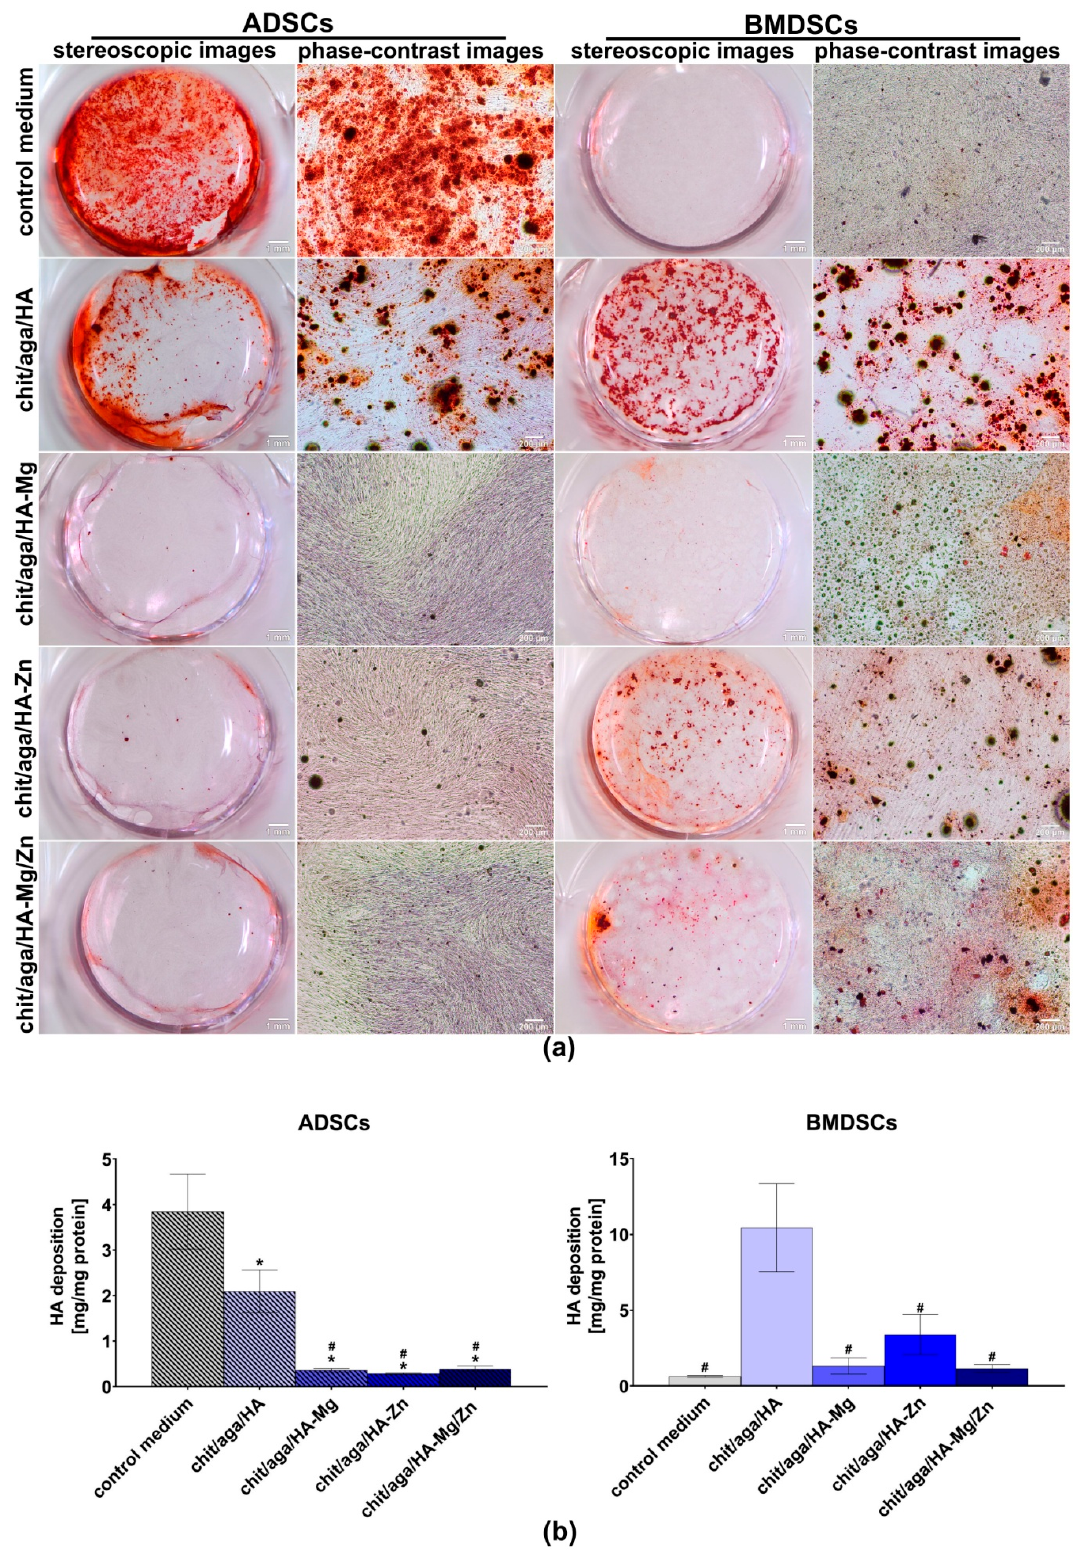
Figure 9. Evaluation of mineral deposition in ECM of MSCs cultured in PS wells in the presence of scaffolds extracts (control medium, cells maintained in osteogenic medium): ( a ) stereoscopic and phase-contrast images presenting ARS staining of bone marrow-derived stem cells (BMDSCs) and adipose tissue-derived mesenchymal stem cells (ADSCs) (stereoscopic images, scale bar = 1 mm and phase-contrast images, scale bar = 200 µm); ( b ) quantitative evaluation of mineral deposits in ECM of